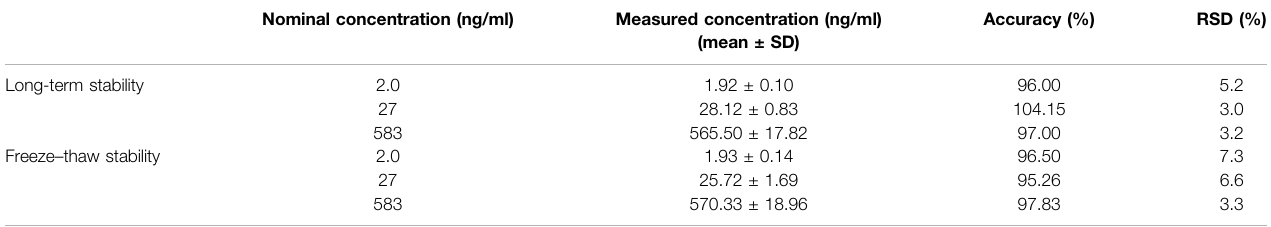
TABLE 4 | Stability of osimertinib in SD rat samples ( n = 6).